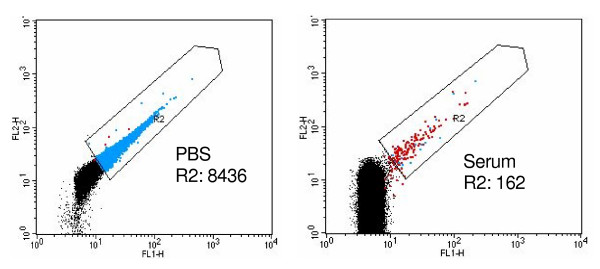
Inhibition of PrP aggregation in serum. FITC-labeled recombinant bovine prion protein (concentration 10 nM) was incubated at 37°C for 20 h with continuous shaking, either in 150 μl PBS (left panel) or in the same volume of serum (right panel), followed by flow cytometry. The measurements are depicted in a Fluorescence 1 (FL1-H) vs. Fluorescence 2 (FL2-H) dot-plot. The number of counts in the area containing specific signals (R2) is given in the figures. Aggregate formation in serum is strongly inhibited.